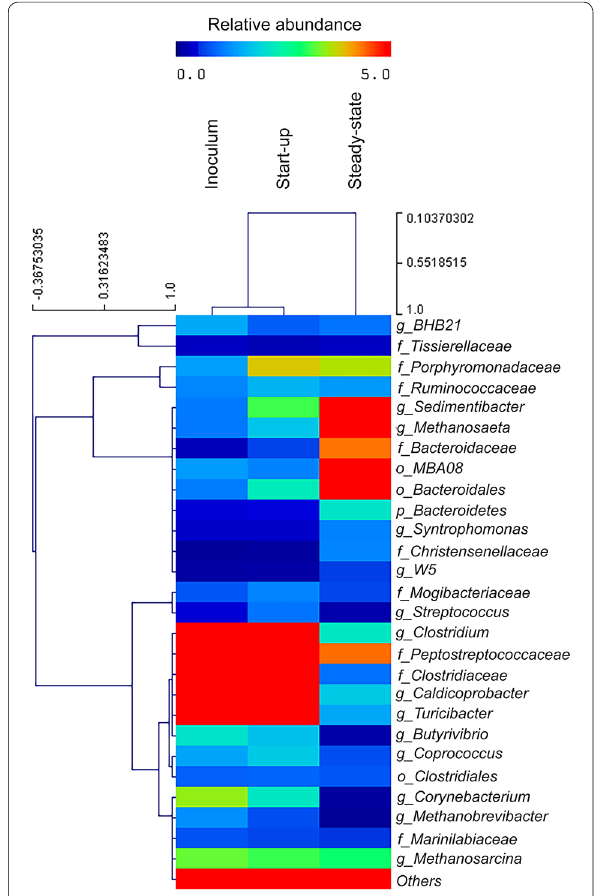
Fig. 3 Heat map shows the relative abundance of the genera in the inoculum, the reactor start-up phase, and steady-state conditions. Only genera with relative abundances > 1% are represented